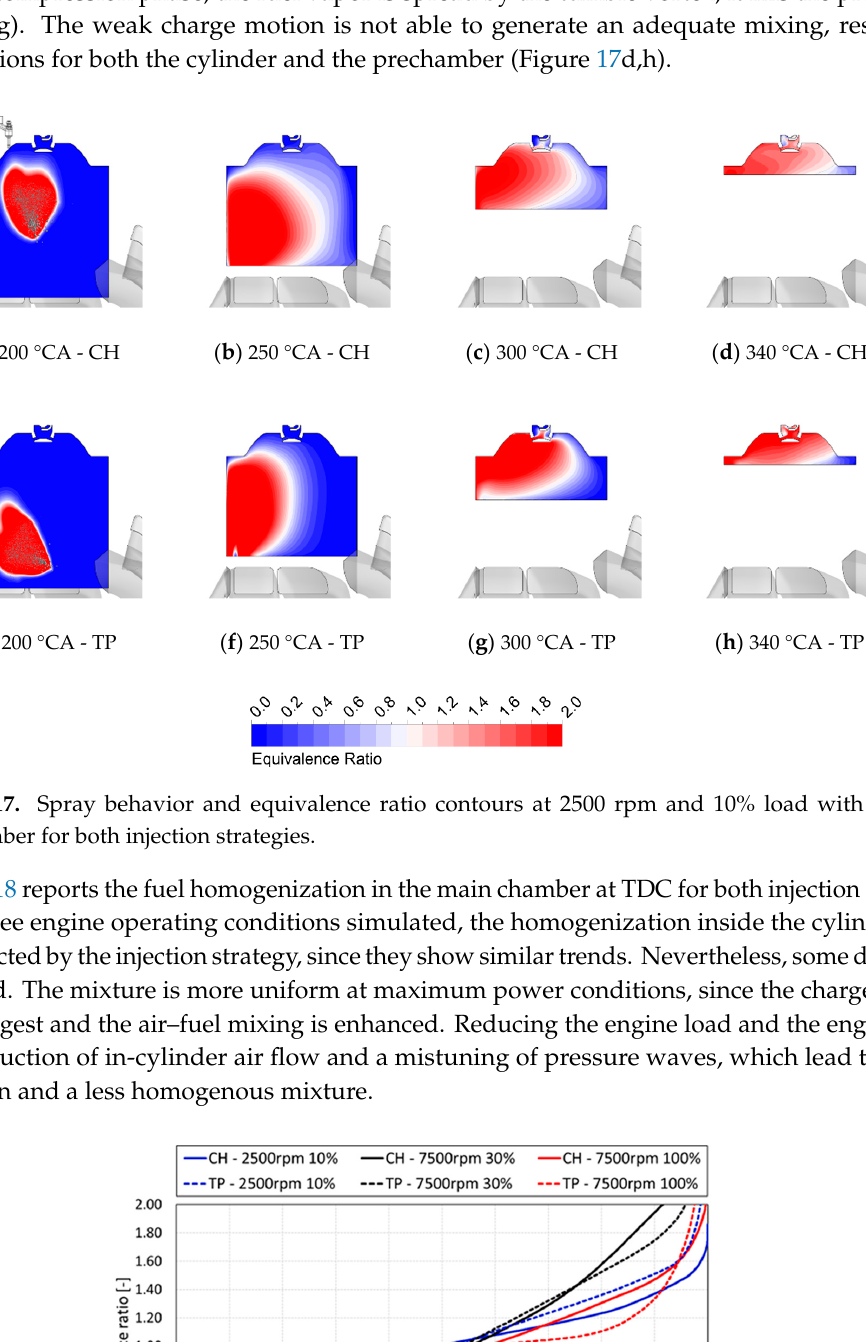
Figure 16. Spray behavior and equivalence ratio contours at 7500 rpm and 30% of load with PN6 prechamber for both injection strategies.